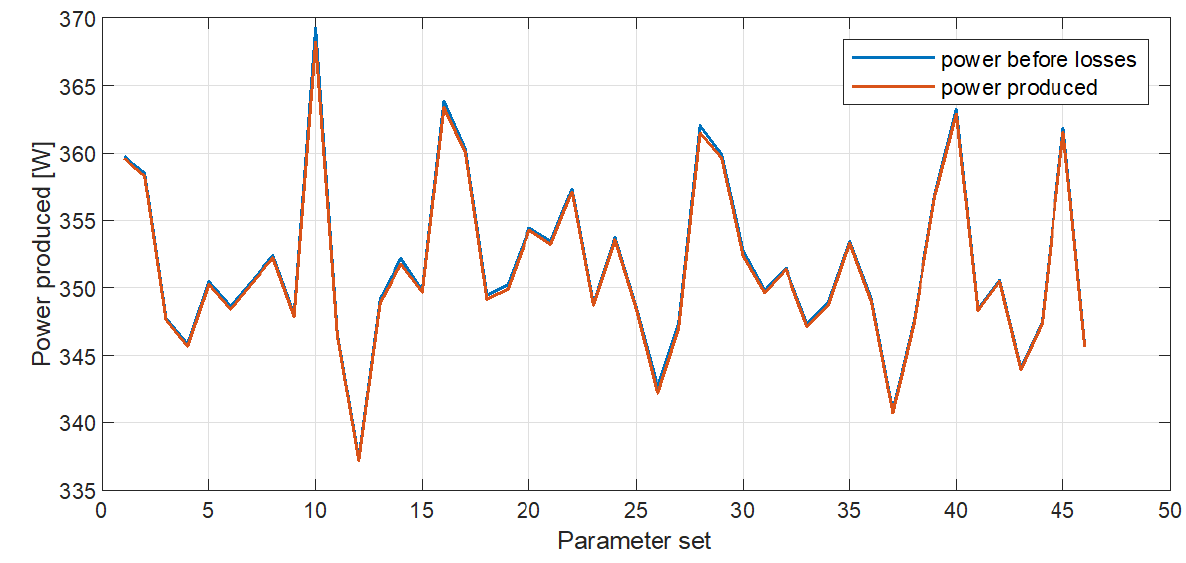
Figure 16. LHS parametric study results.